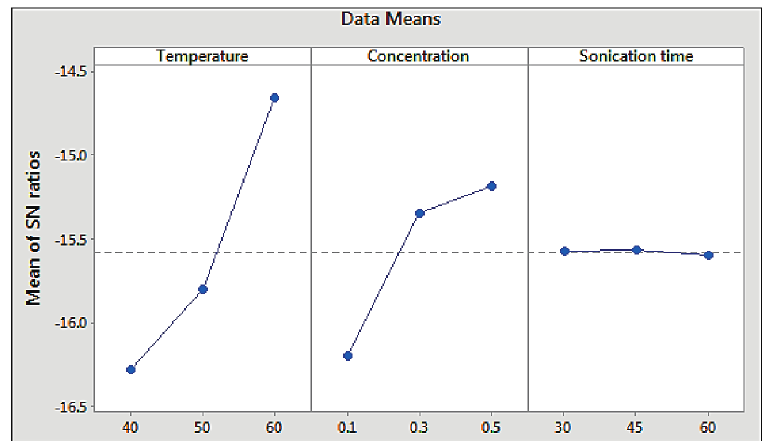
Figure 6: S/N ratio effect on thermal conductivity (unmilled process).